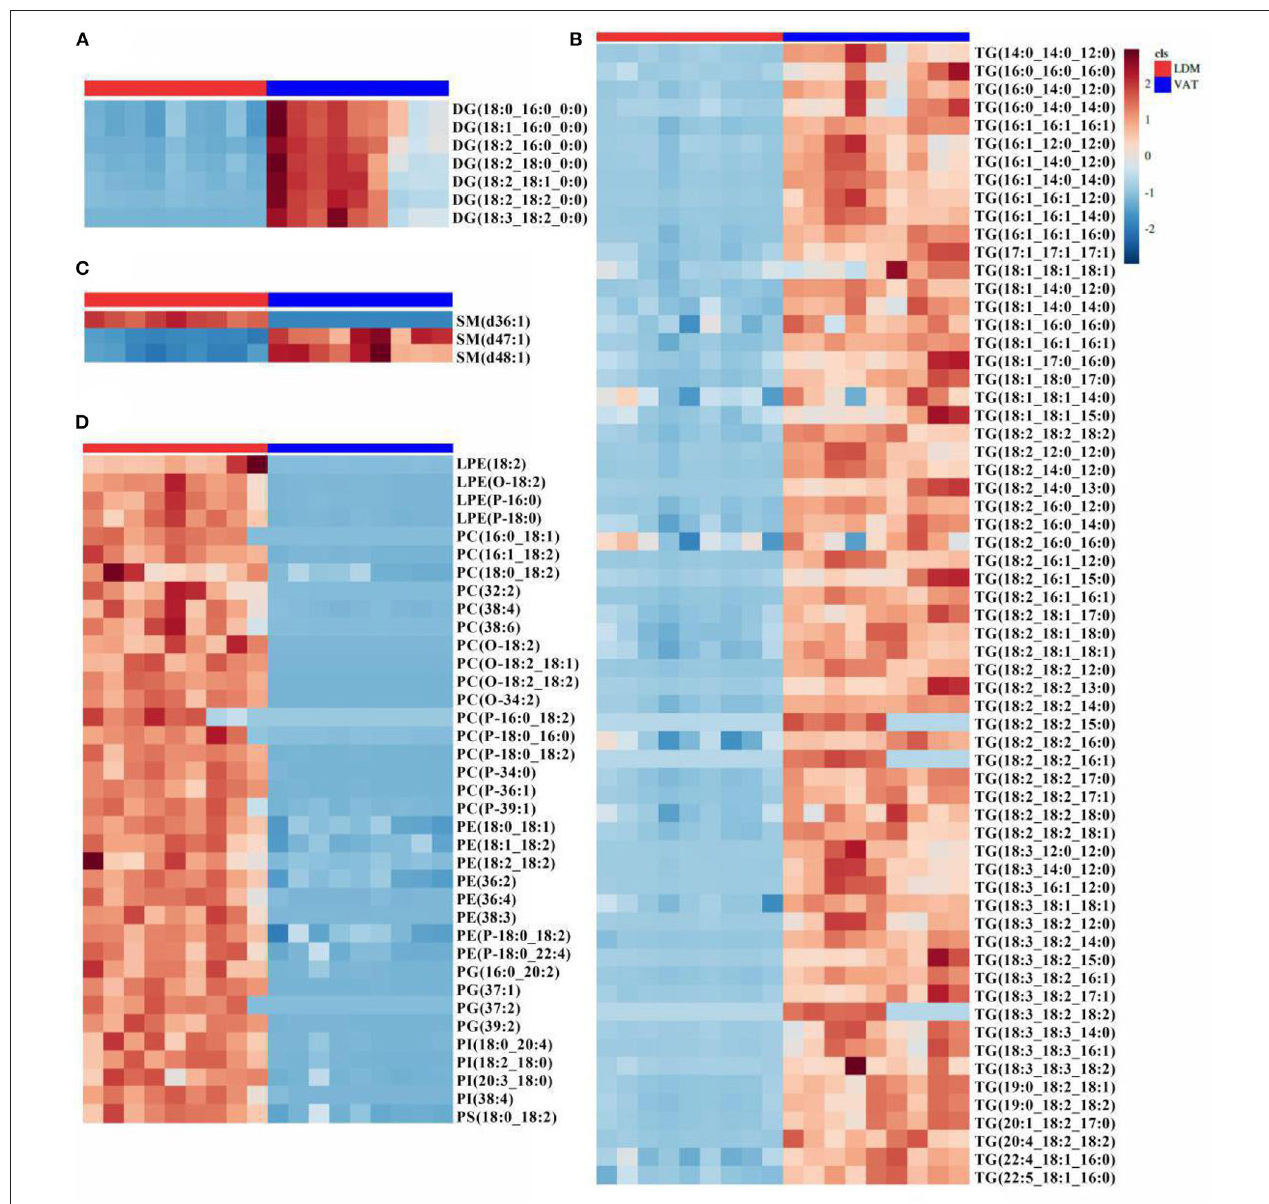
FIGURE 3 | Difference in lipid molecules of donkey LDM and VAT. Heatmap analysis of (A) DG, (B) TG, (C) SP, and (D) GP molecules. Colors indicate decreased (blue band) or increased (red band) levels of lipid molecules in LDM vs. VAT. DG, diacylglycerol; TG, triglyceride; SP, sphingolipids; GP,